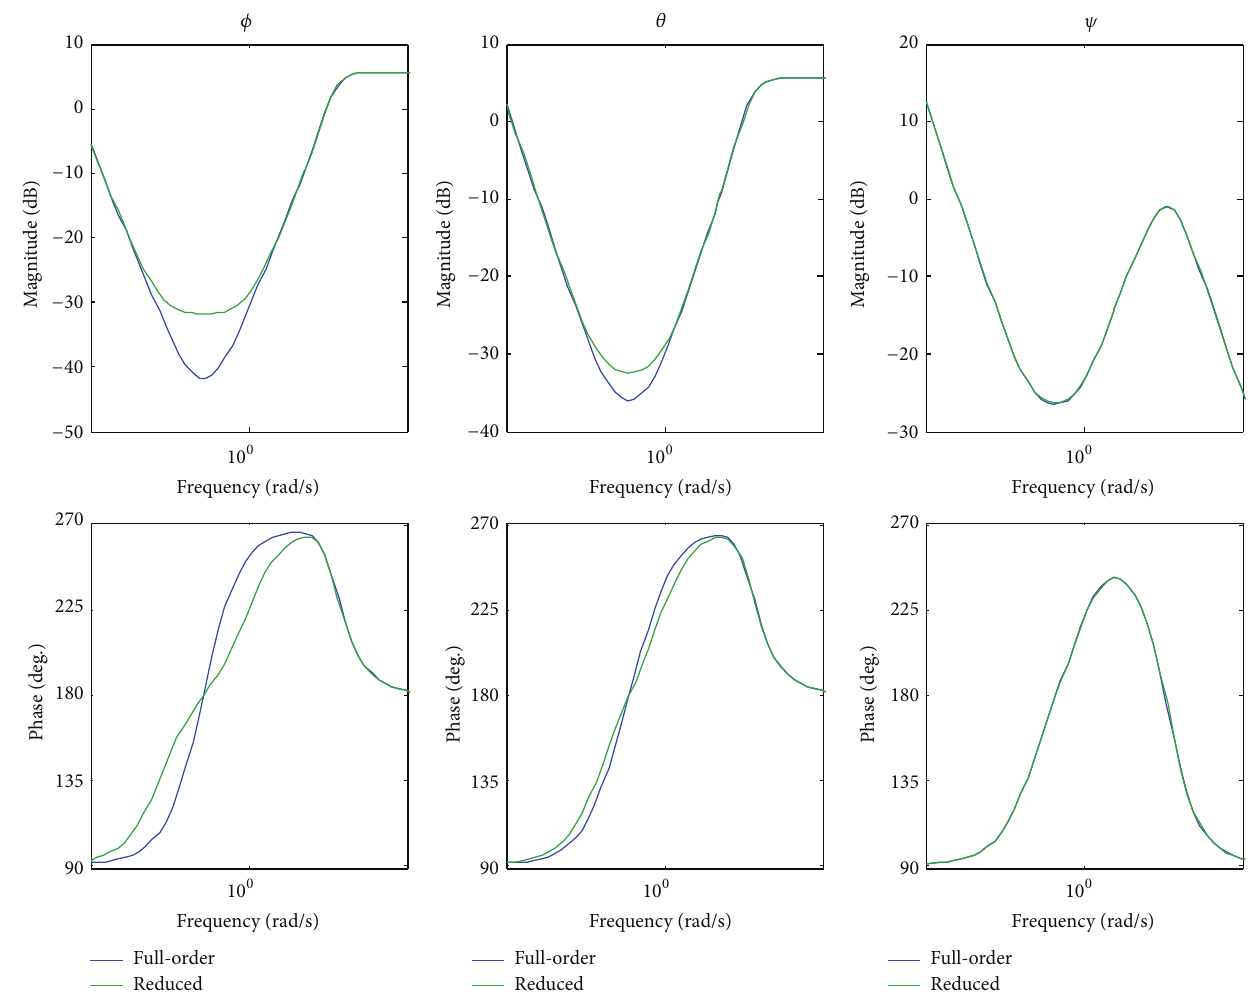
Figure 4: Comparison with the original and deduced 𝐻 ∞